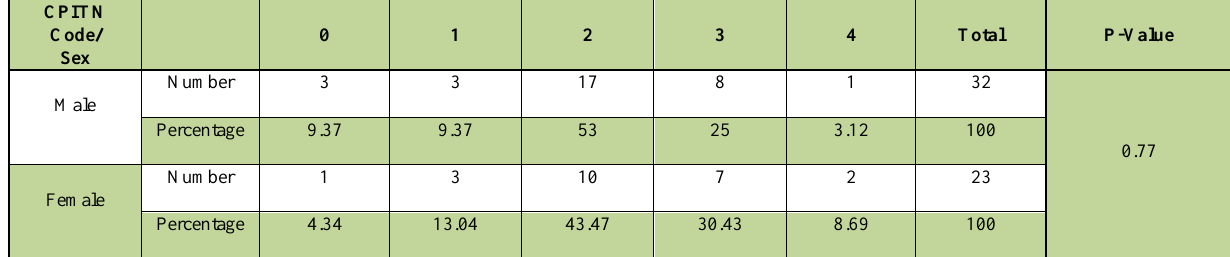
Table 3. Frequency distribution of CPITN index in the subjects studied by gender.